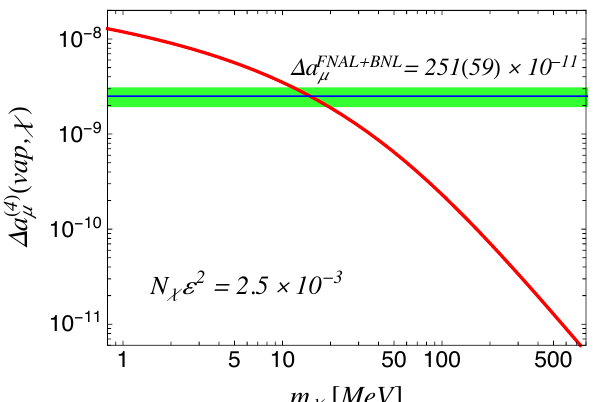
Figure 2 . The two-loop contribution to muon g − 2 from millicharged particles through one-loop photon vacuum polarization for N χ ε 2 = 2 . 5 × 10 − 3 . The green band corresponds to (251 ± 59) × 10 − 11